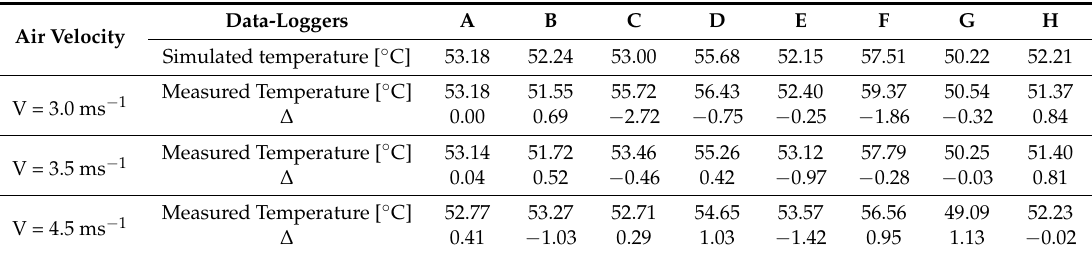
Table 6. Measured and simulated temperatures at the same points of the floor between 12:00 a.m. and 6:00 a.m. on 26 April 2014 and related temperature differences. Sensitivity analysis with variable values of the air velocity at the lower cavity.